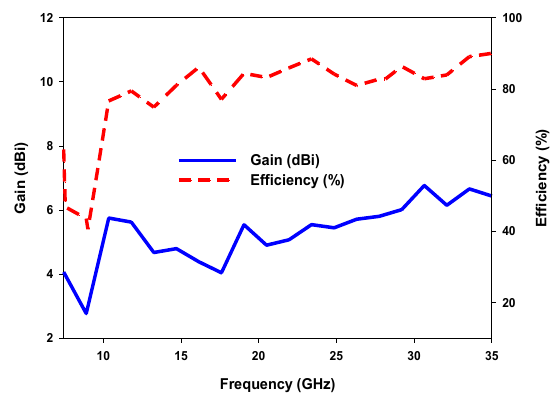
FIGURE 12. Gain and Radiation Efficiency of the proposed triple band